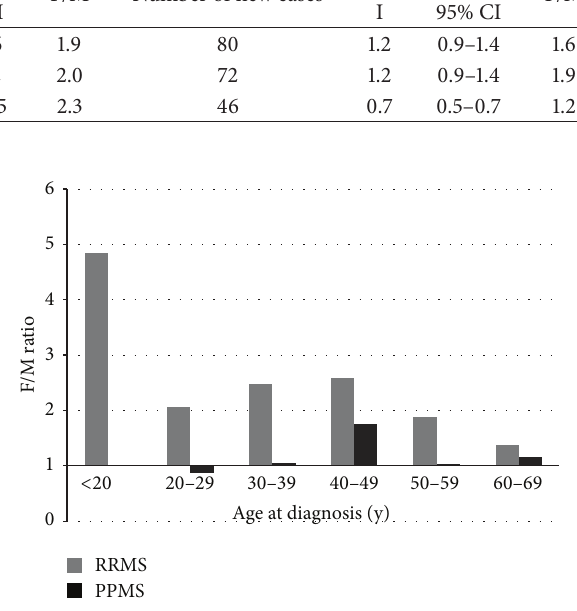
Figure 2: F/M ratios in ten-year age groups. F/M ratio in RRMS remained about twofold or higher from 20 to 59 years and in PPMS ratio was about 1:1, except for a slightly higher ratio in the 40–49 age group. The F/M ratio in RRMS is significant in age group younger than 20 years, where the ratio of women to men was 5 : 1 ( 𝑁 = 34 /7 cases), and no PPMS cases were observed.